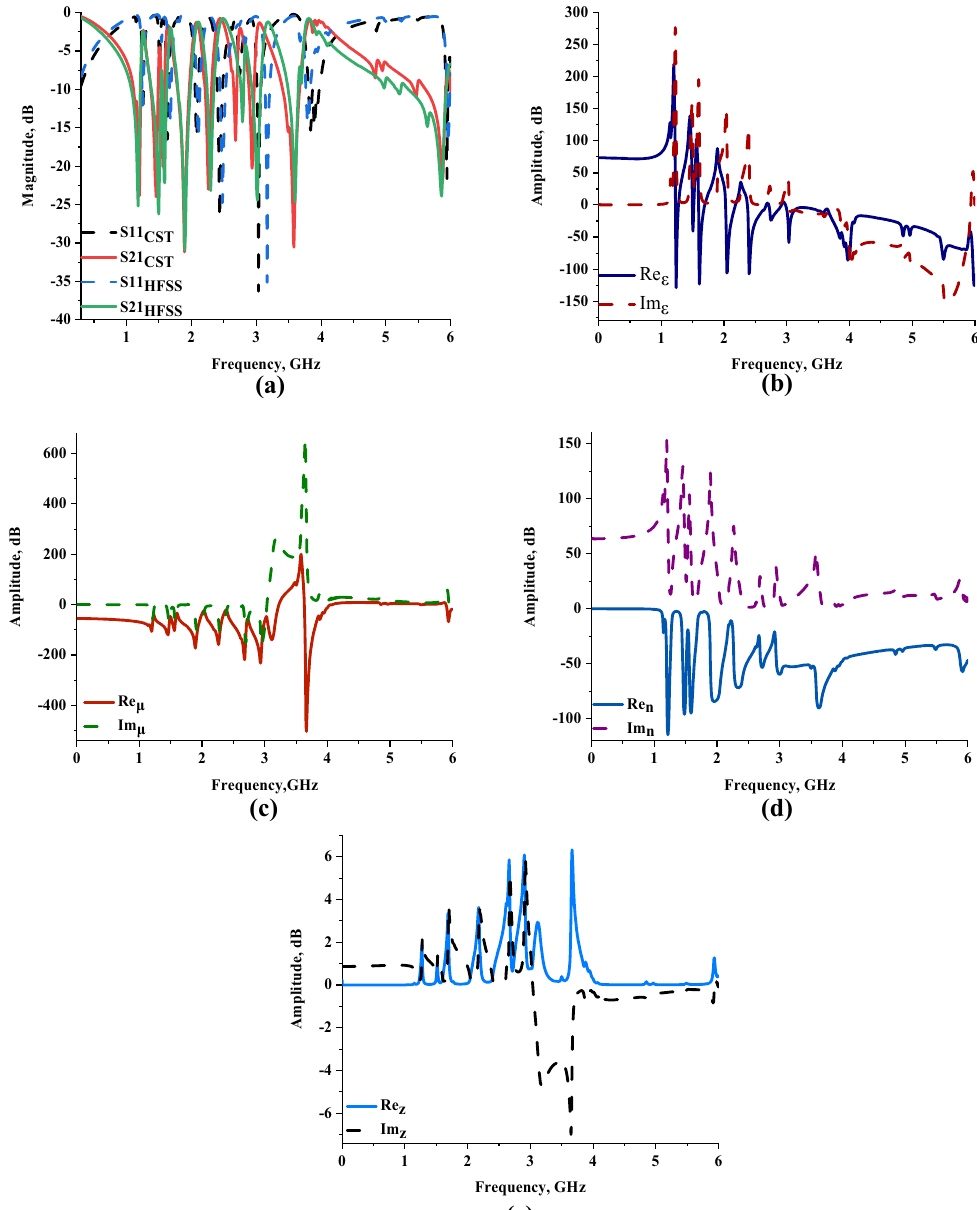
Figure 3. Scattering (from CST & HFSS) and effective medium parameters of the MSM design (from MATLAB): (a) Numerically simulated S11 and S21 results, (b) Permittivity, (c) Permeability, (d) Refractive index, (e) Impedance